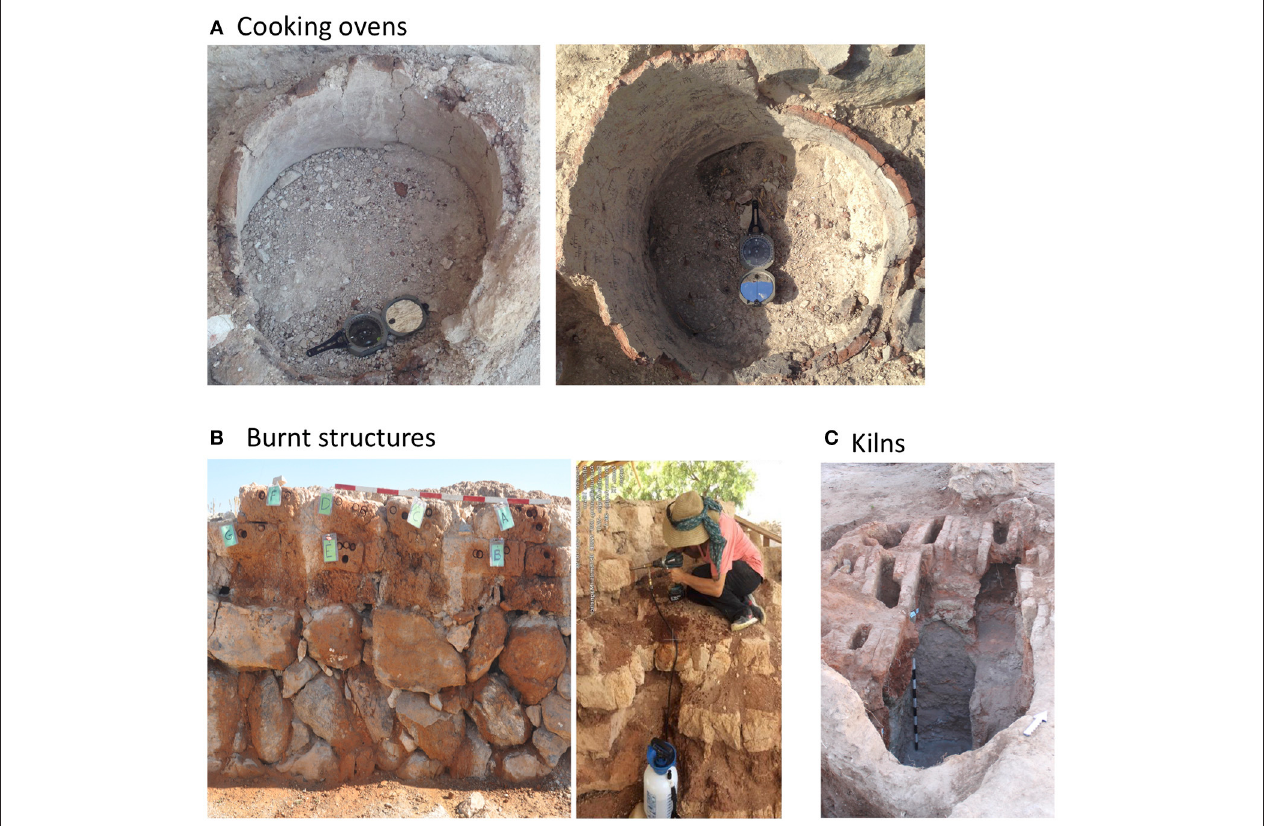
FIGURE 2 | Types of archaeomagnegic structures used in this study: (A) Cooking ovens (tabuns) from Herodium (left) and Abel Beth Maacah (right). (B) Burnt structures from Tel ‘Eton (left) and Tel Hazor (right). (C) Ceramic kilns from Yavneh. For a figures and archaeological information of all sites see Supplementary Material .